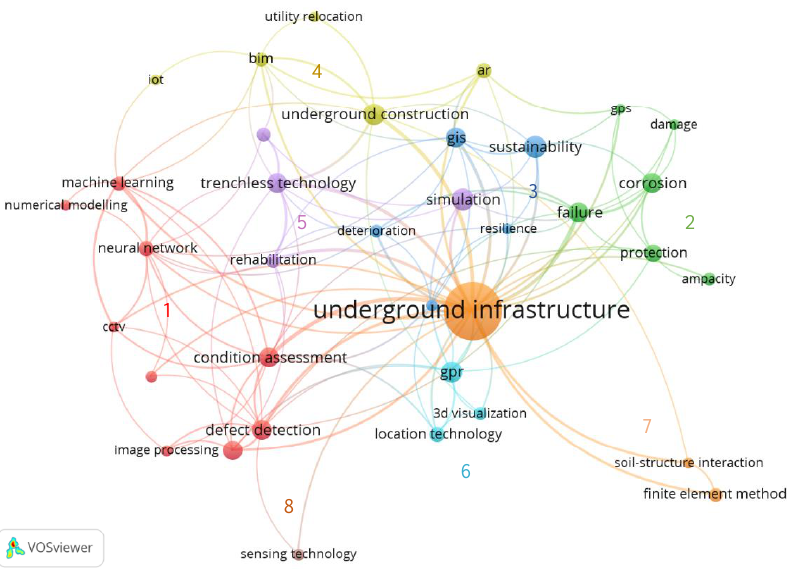
Figure 9. Co-occurrence network of author keywords in UI research domain.